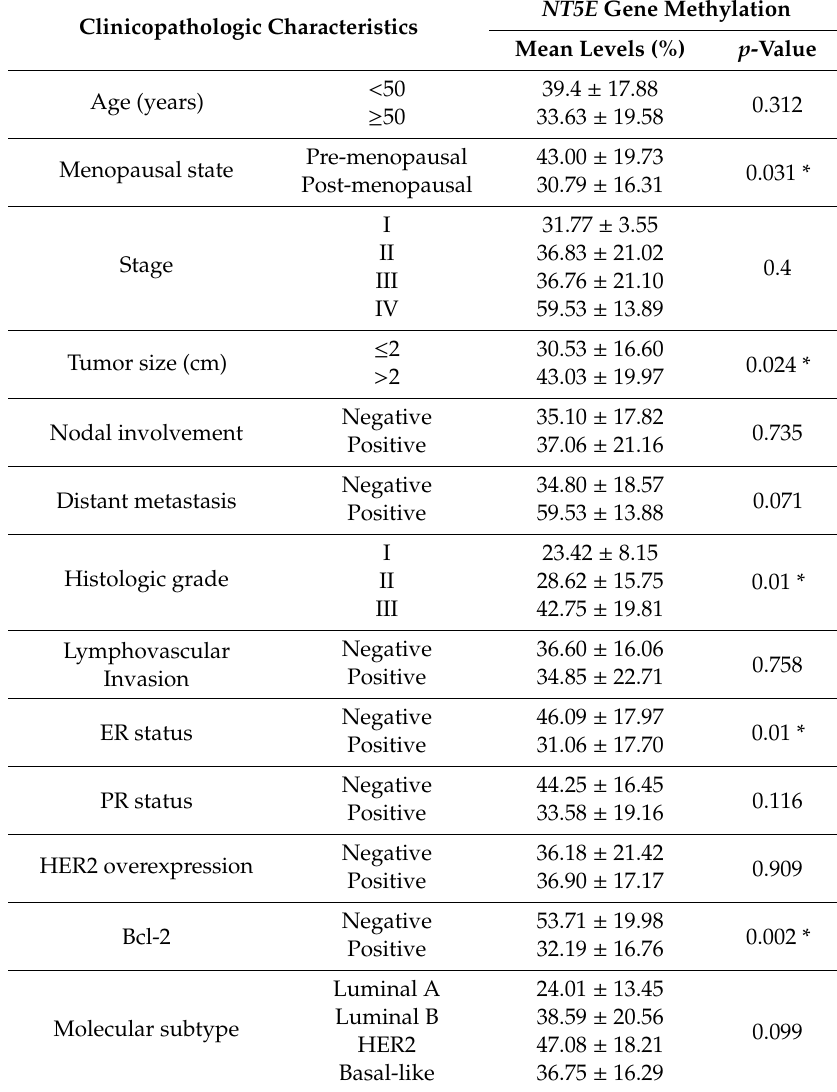
Table 2. Association of methylation level of the NT5E gene with clinicopathologic